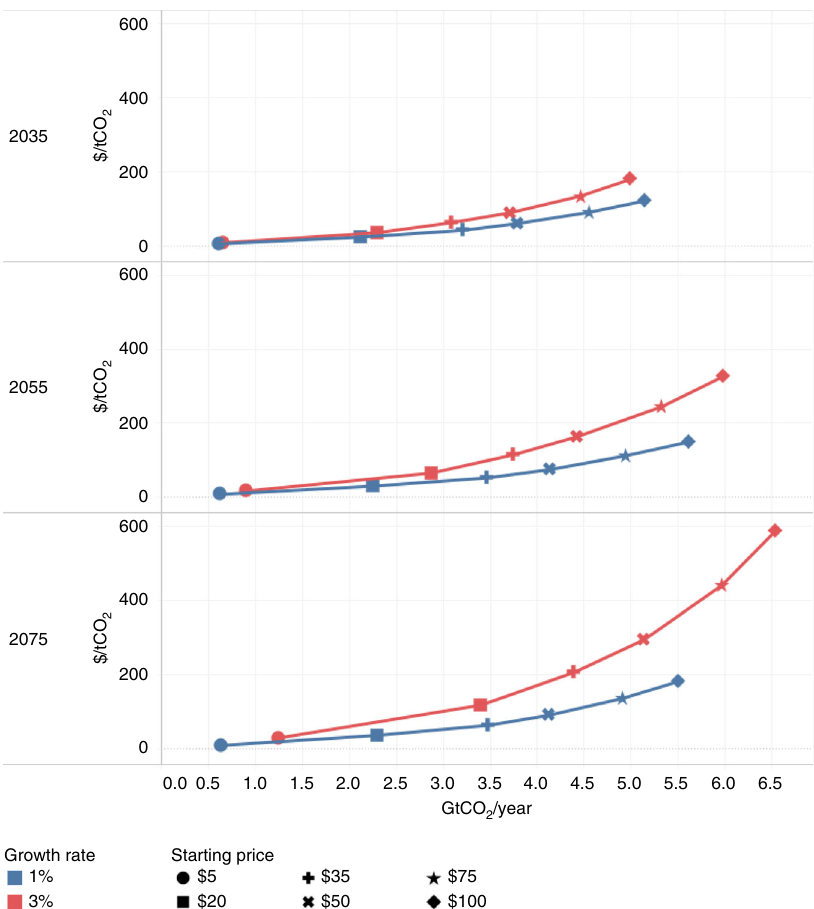
Fig. 1 Global marginal abatement cost curves in the global forest sector. We project mitigation quantities and costs across three time-horizons: 2035 (top), 2055 (middle), and 2075 (bottom), under six starting prices and two growth rate